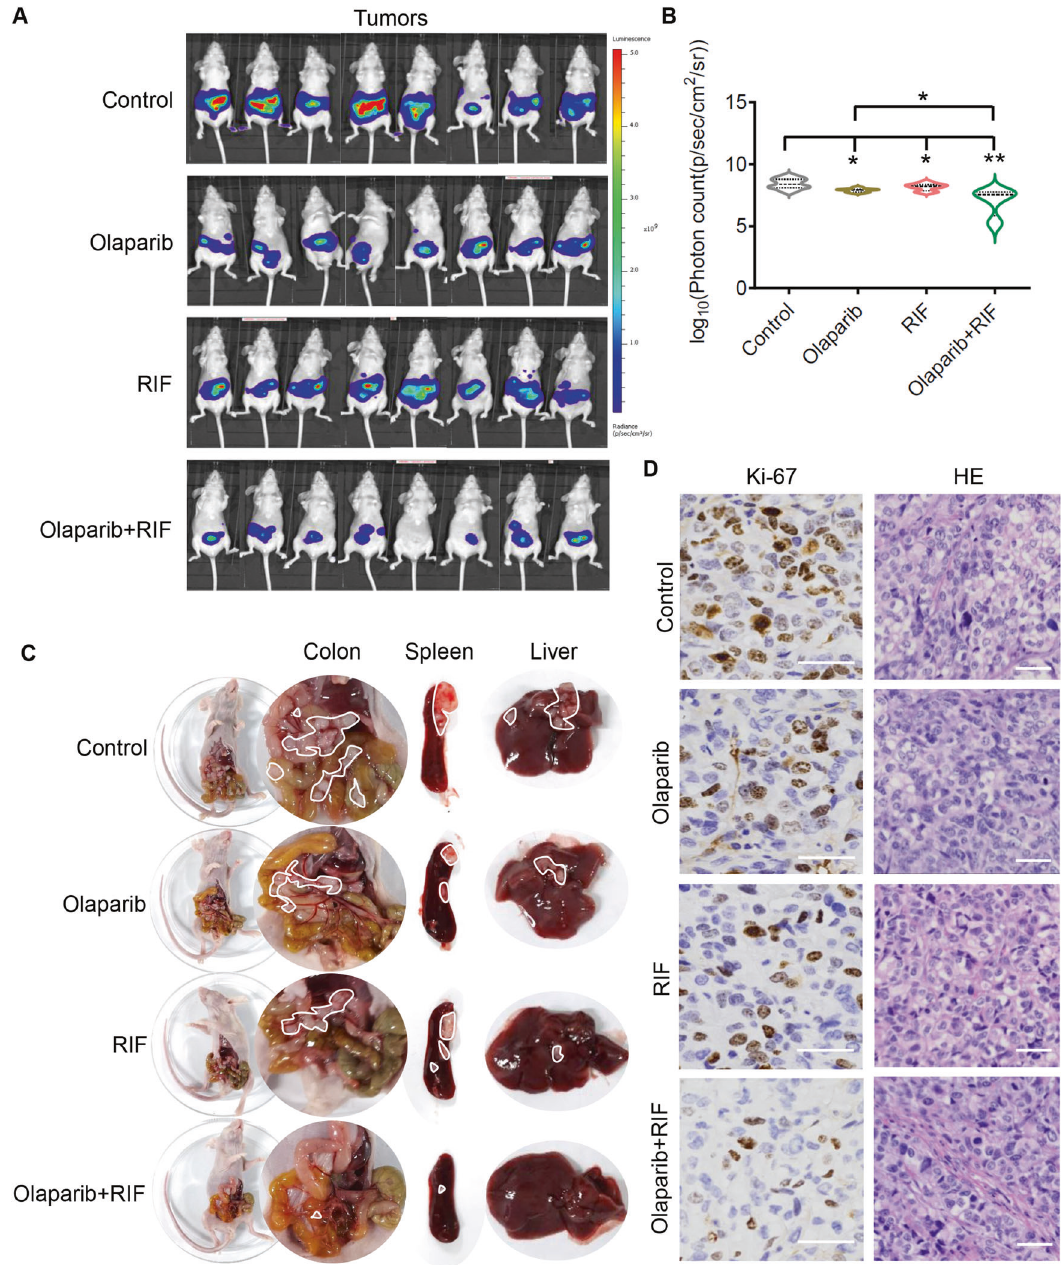
Fig. 6 Low dose of RIF sensitizes SKOV3-derived xenograft tumors to olaparib in vivo. A Female BALB/c nude mice bearing luciferized SKOV3-derived tumors were randomized into four treatment groups and treated with vehicle control, low dose of RIF (135 mg/kg, daily by i.g.), olaparib (100 mg/kg, daily by i.g.), or RIF/olaparib combination for each model till 3 weeks ( n = 8 mice per group). Tumor growth was monitored by weekly bioluminescence imaging of the mice. Representative images of mice bearing SKOV3 xenografts. B Tumor burden at the end of the treatment is represented as mean ± SD. C Representative images of the abdominal tumor nodules in colon, spleen, and liver in the four different treated groups are shown. D Tumors dissected from the SKOV3 xenografts with the indicated treatments were examined for Ki-67 protein expression by IHC and HE staining. Scale bar, 100 μ m. * P < 0.05; ** P <